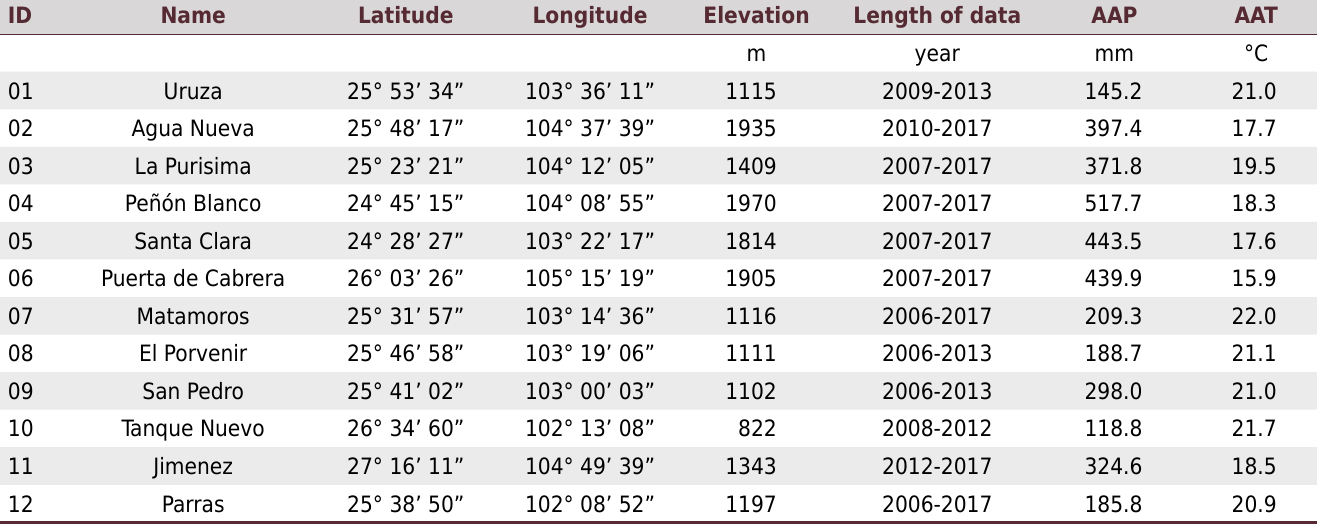
Table 2. Location and characteristics of the weather stations